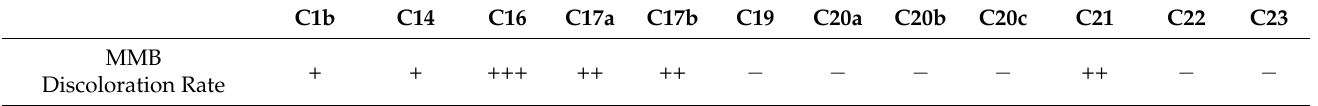
Table 2. Mn solubilization abilities by visual discoloration of manganese minimal basal (MMB) medium of the twelve isolates. The solubilization abilities were indicated as follows: high discol- oration (+++); medium discoloration (++); low discoloration (+); no discoloration ( −